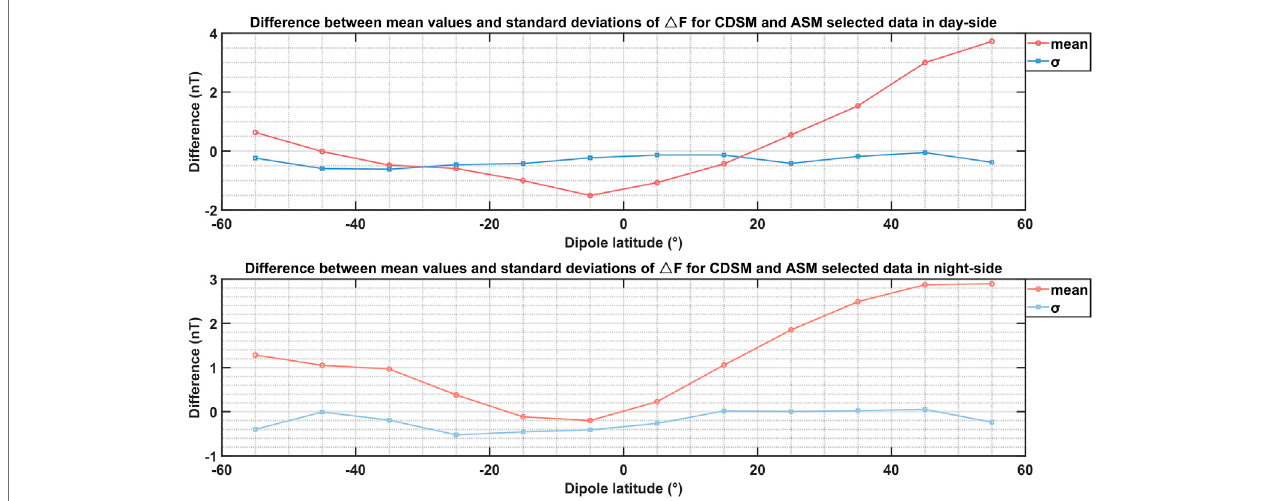
FIGURE 8 | Difference between mean values and standard deviations of Δ F for the CDSM and for ASM selected data from July 31 to 30 September 2019.